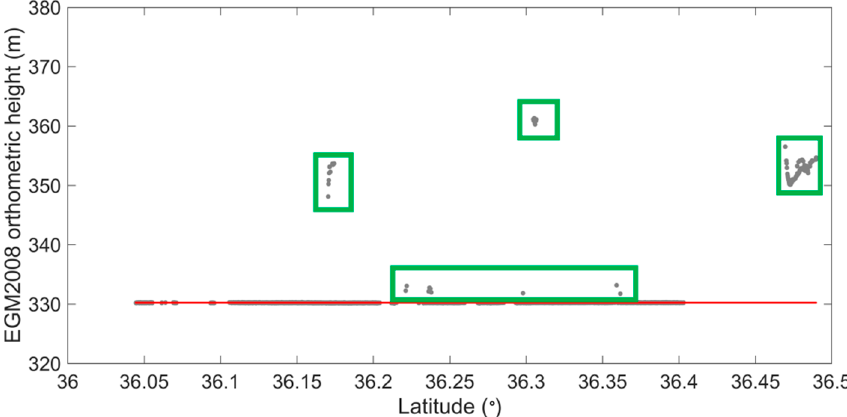
Figure 1. Extraction of lake water level from ICESat-2 ATL13 profiles in a sampled ICESat-2 acquisition date and discarding outliers by obtaining the median of water levels. Green boxes correspond to the ICESat-2 points on the shore (such as forest, shrub, and bare land) around the lake, which were discarded when calculating the water level on that day by a median-based filter. The red horizontal line represents the calculated water level on that day.